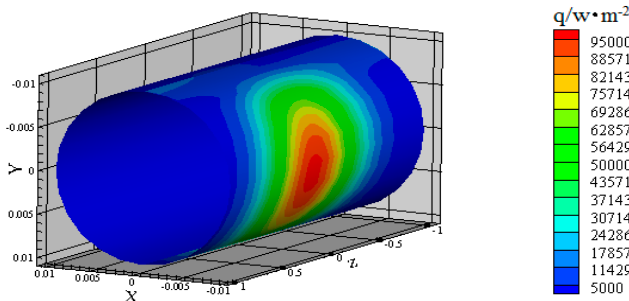
Figure 5. 3D heat-flux distribution on the outer tube’s wall.